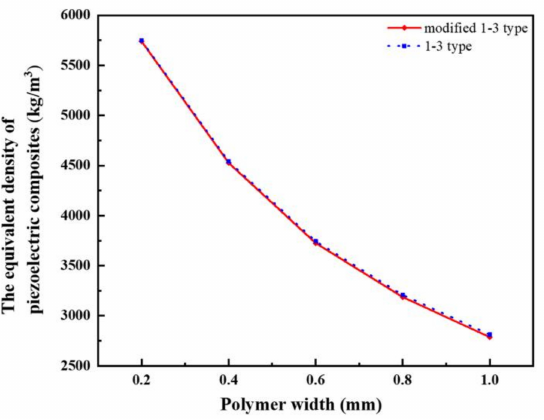
Figure 10. The change curve of equivalent density of the two types of